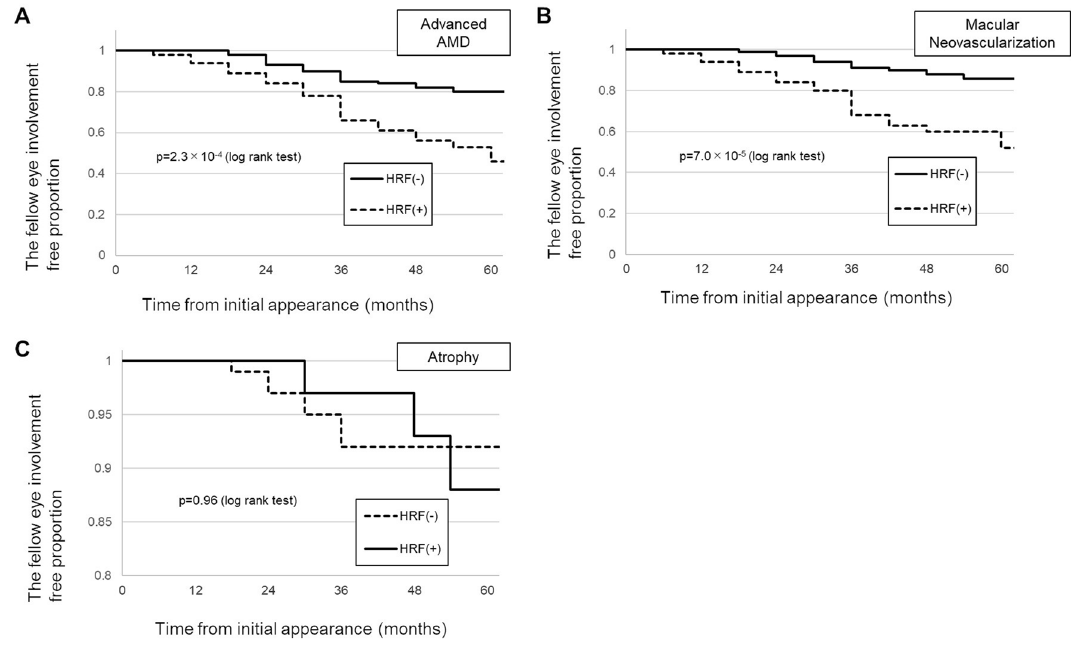
Figure 2. Kaplan–Meier survival curve demonstrating progression from intermediate to advanced AMD with or without HRF. ( A ) Kaplan–Meier survival curve (KM curve) of the time to progression to advanced AMD. The proportion of patients who progressed to advanced AMD at 60 months is 53.8% and 19.6% in the HRF (+) and HRF (−) groups, respectively. HRF is associated with the progression and time to progression of advanced AMD ( p = 2.3 × 10 −4 , log-rank test). ( B ) KM curve of the time to progression to MNV. The proportion of patients who progressed to MNV at 60 months is 47.5% and 14.2% in the HRF (+) and HRF (−) groups, respectively. HRF is associated with the progression and time to progression of MNV ( p = 7.0 × 10 −5 , log-rank test). ( C )